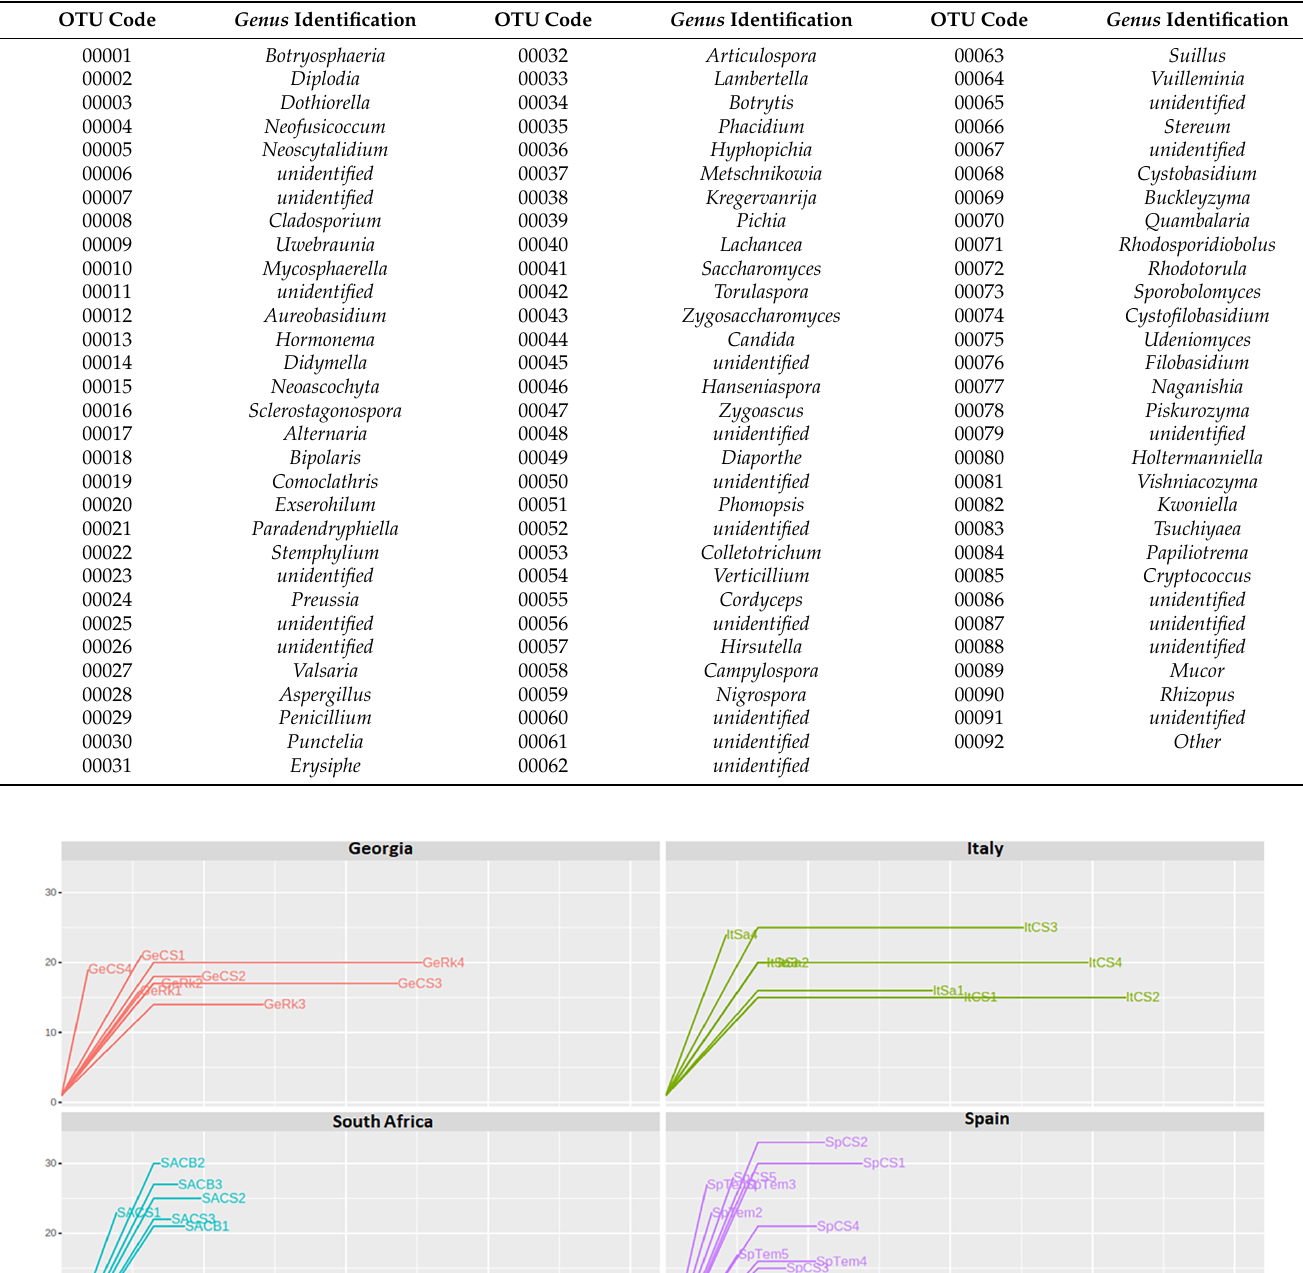
Table A2. Assignment between OTU codes and genera.